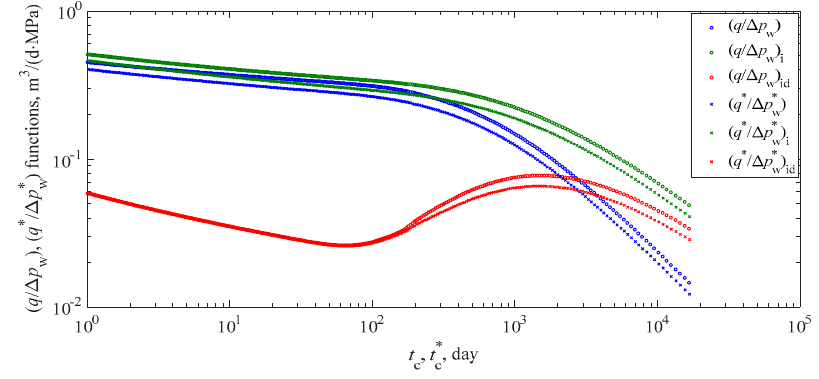
Figure 22. Normalized rate functions and modified normalized rate functions for Case 3.